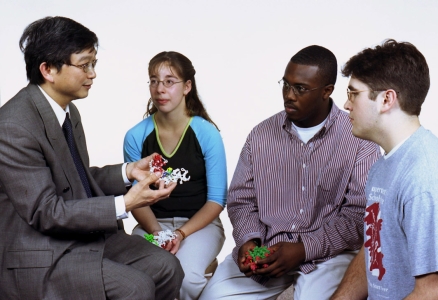
Structural Insights into Anthrax PathogenesisWei-Jen Tang (left) discusses a physical model of the anthrax edema factor with the Riverside High School SMART Team.